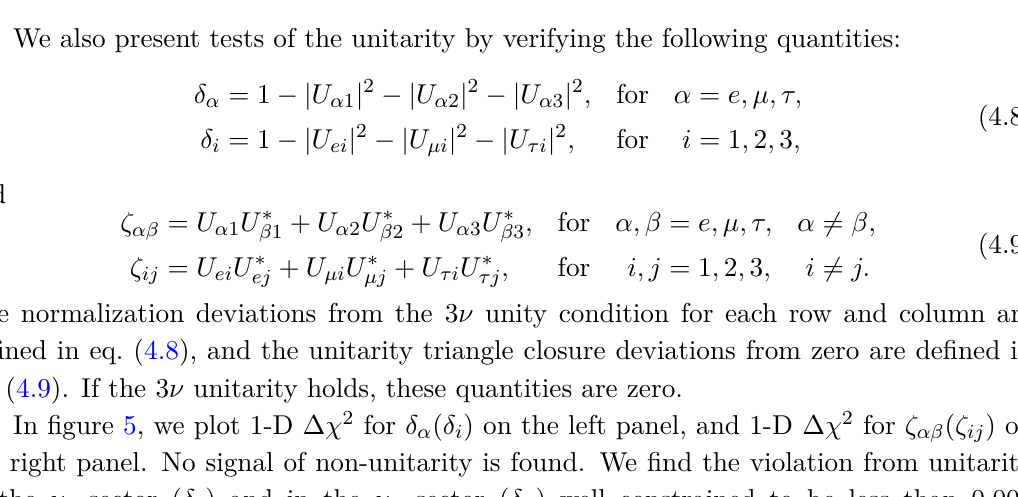
Figure 5 . Constraints on the non-unitarity. Left : the normalization deviations from unity of each row and column. Right : the deviations of unitarity triangle closure. Any non-zero terms among these quantities indicate non-unitarity. No signal of unitarity violation is found. The curves show upper bounds on the corresponding non-unitary